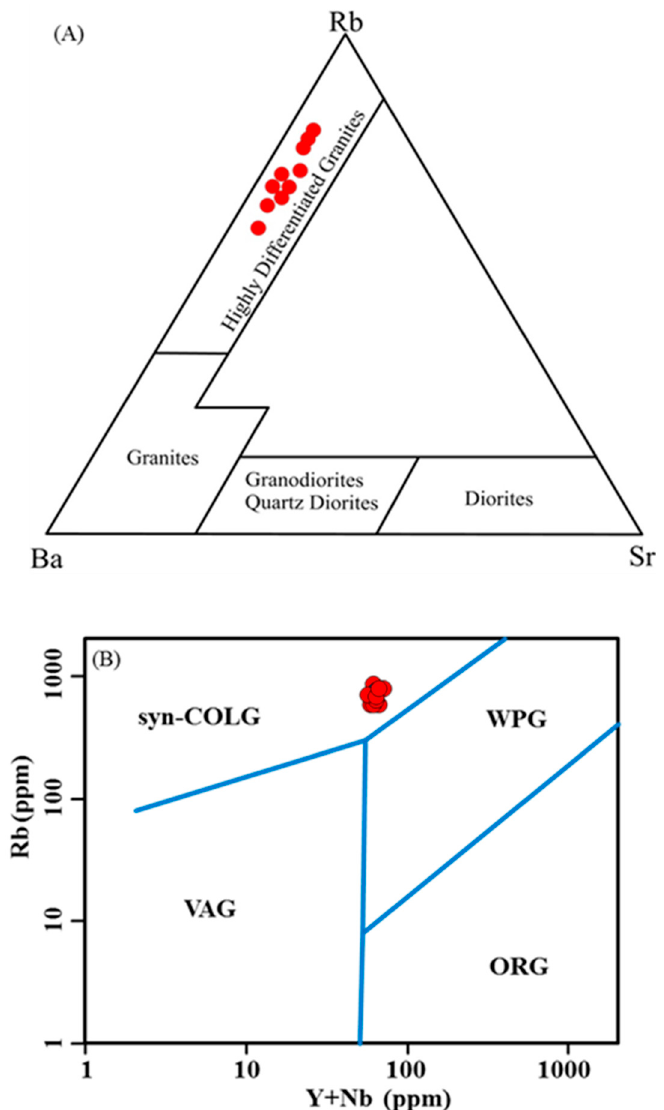
Figure 7. Rb–Sr–Ba triangular diagram. ( A ). Rb–Sr–Ba triangular plot pointing out the genetic aspect of the Tagu granitoid [31]; ( B ). Y + Nb versus Rb diagram showing the tectonic setting [32] of the Tagu granitic rocks. Syn-COLG = syncollisional granites; VAG = volcanic-arc granites; WPG = within-plate granites; ORG = oceanic ridge granites.